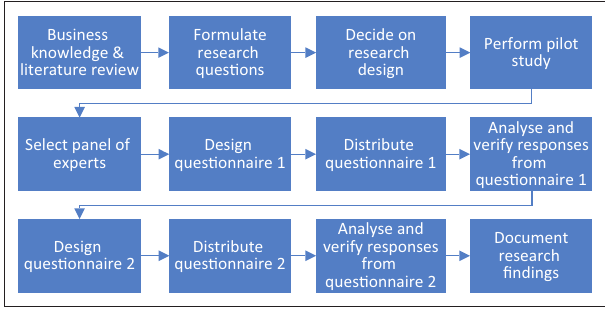
FIGURE 1: Application of the Delphi research technique in this